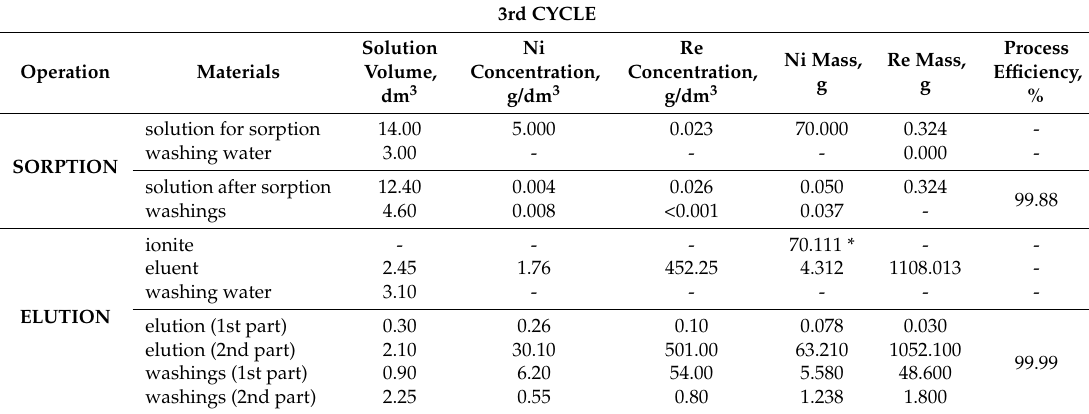
Table 17. Balance for nickel(II) sorption and elution—3rd cycle. 3rd